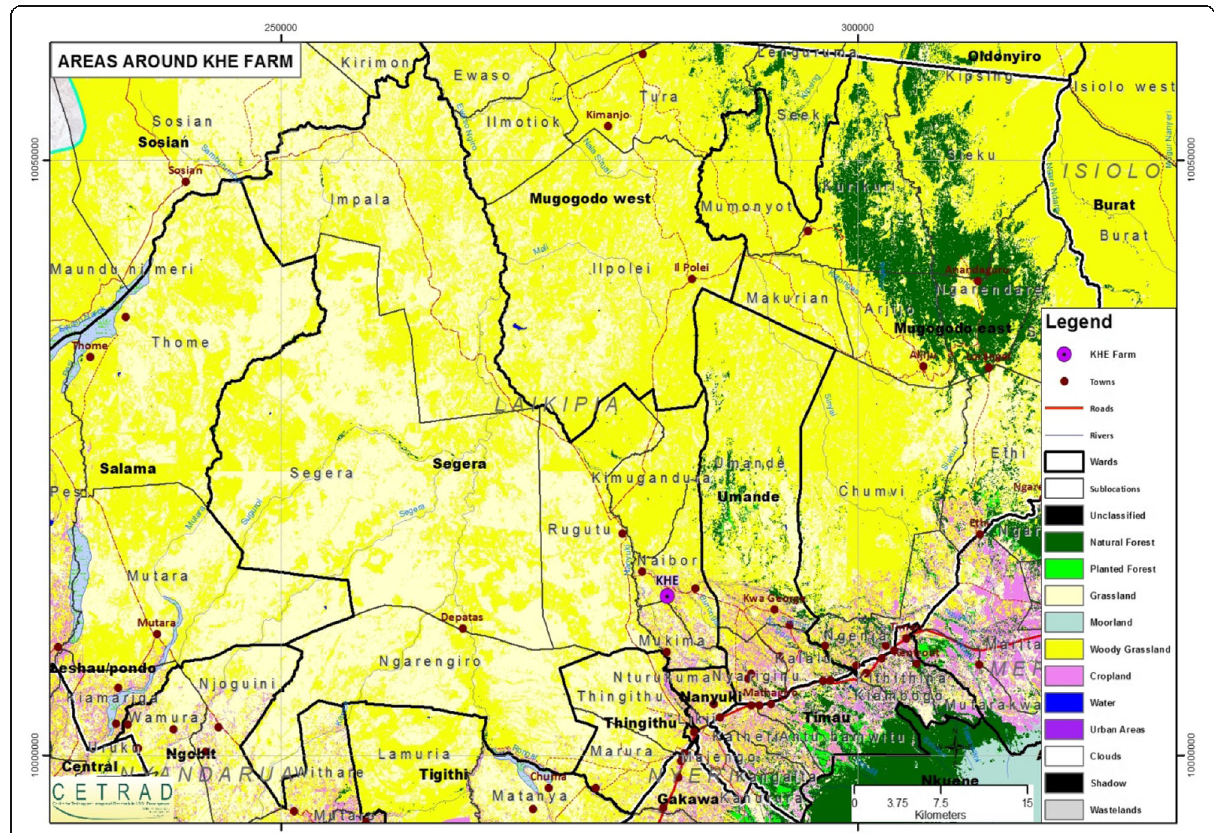
Figure 2 Map of the study area: Laikipia North